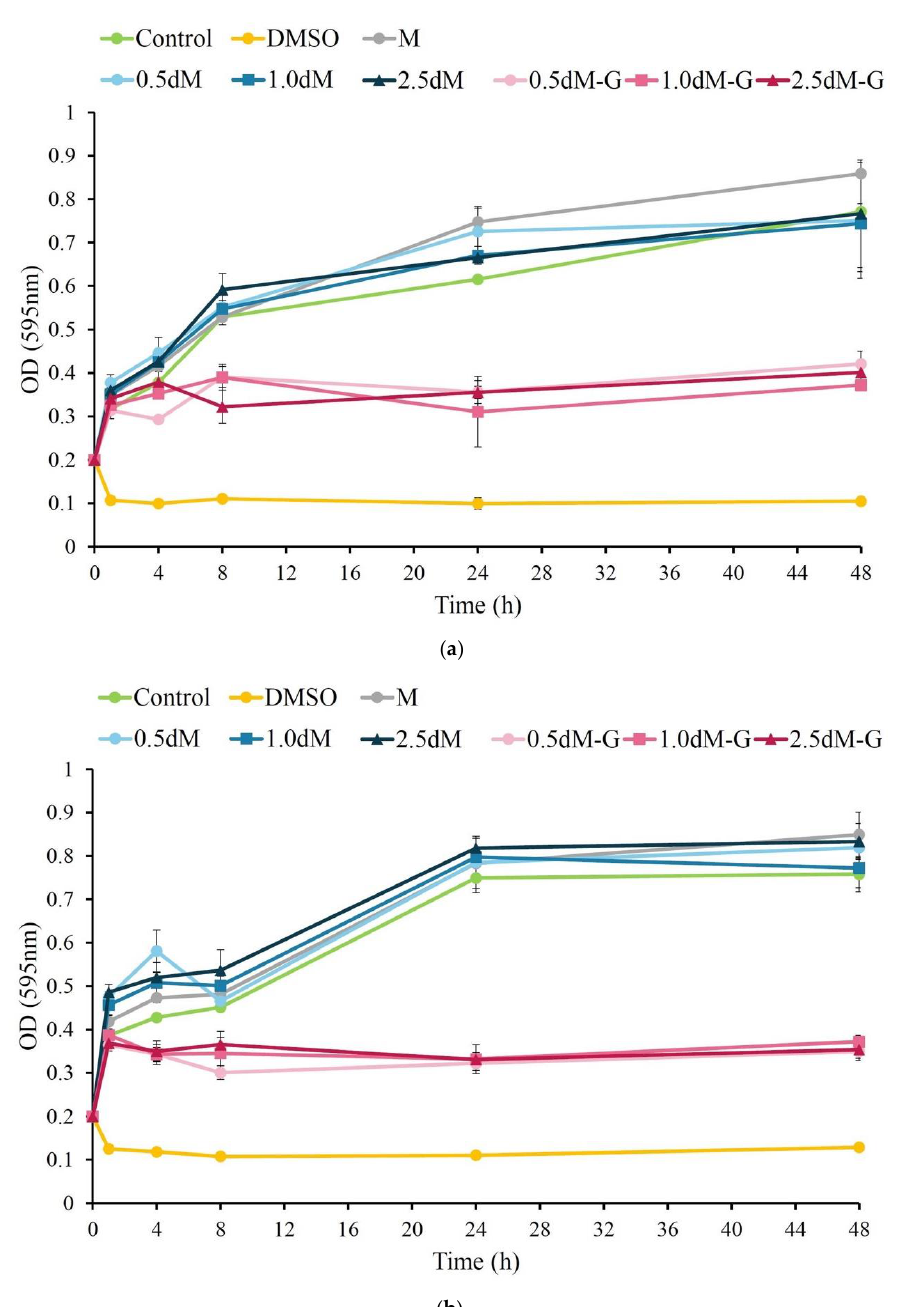
Figure 6. Antibacterial activities of antibiotic-free and DAP-modified microspheres impregnated with antibiotics against ( a ) S. aureus and ( b ) E. coli for a zone of inhibition of 1 day ( n = 3).